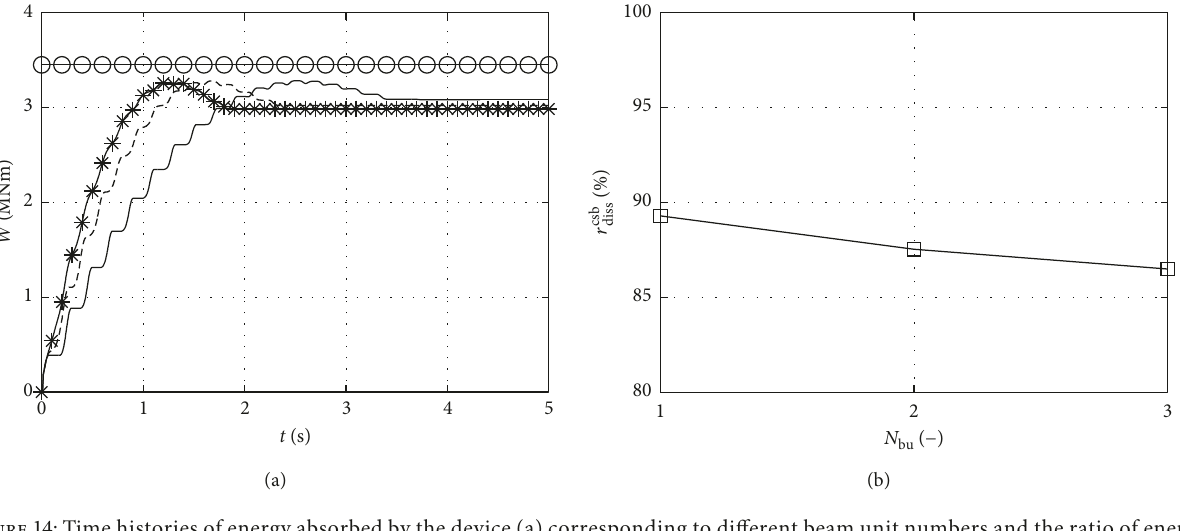
Figure 14: Time histories of energy absorbed by the device (a) corresponding to different beam unit numbers and the ratio of energy absorbed by the device after impact to the total impact energy, respectively, versus beam unit number in one plane N bu (b). , W total ; , the ratio of energy absorbed by the device after impact to the total impact